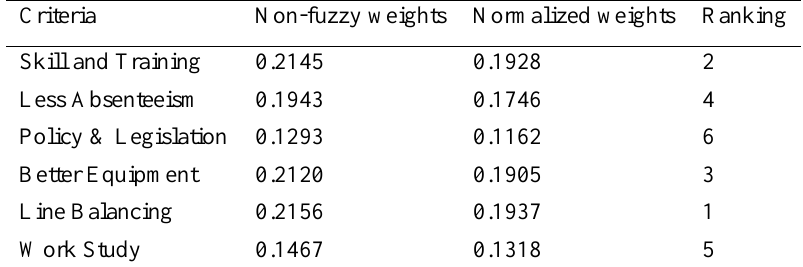
Table 6. Normalized weight of each criterion by FAHP.